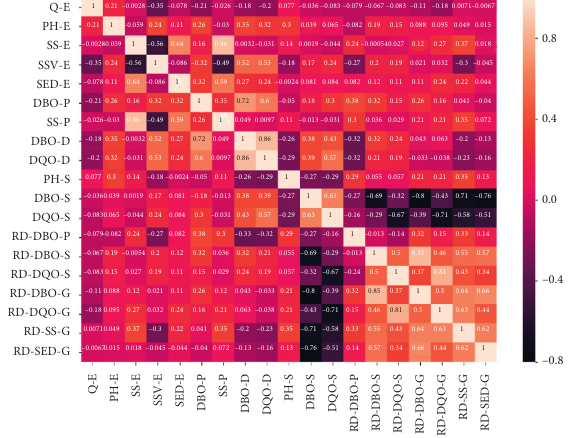
Figure 4: Pearson’s linear correlation.